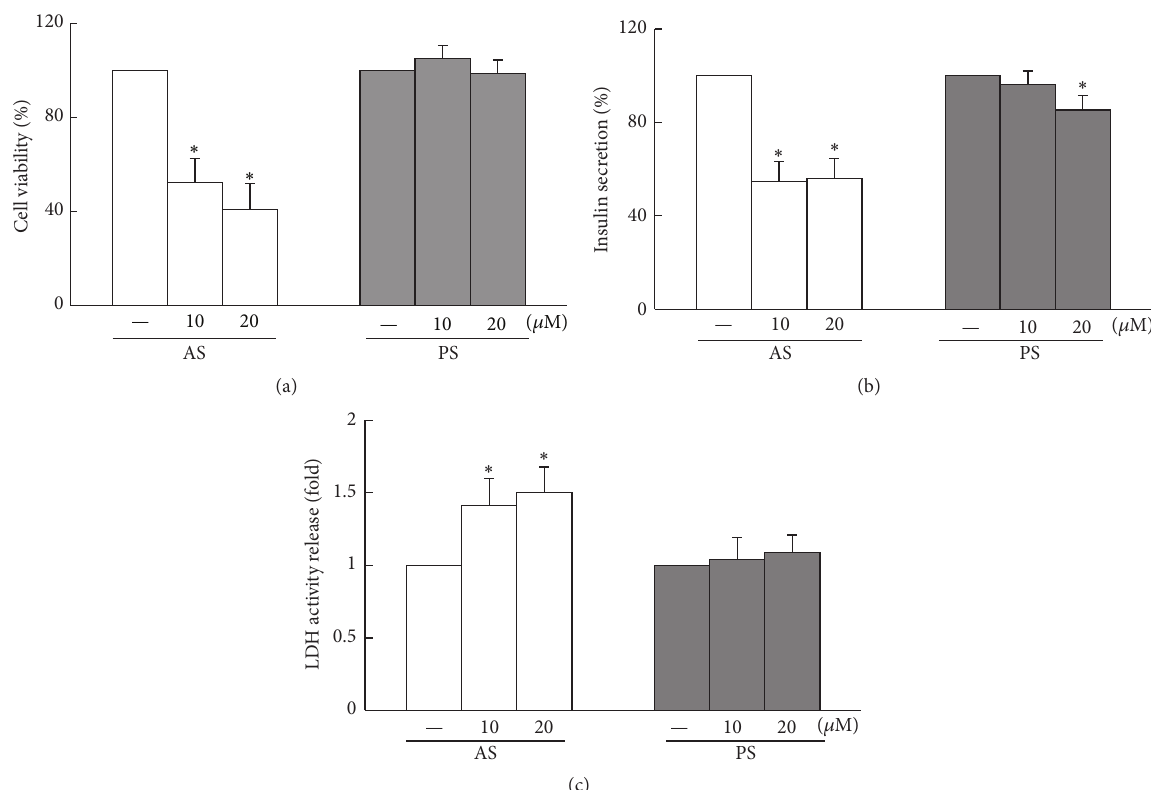
Figure 1: AS not only induces NIT-1 𝛽 cell death but also reduces insulin secretion. (a) Significantly dose-dependent cell death induced by AS in NIT-1 cells; no cell death in PS-treated cells. (b) Insulin secretion decreased considerably in NIT-1 cells after AS treatment and PS treatment with an increased dose. (c) The 48h incubation of AS evidently increased the content of LDH in NIT-1 cells. Data are presented as mean ± SD from three independent experiments ( ∗ 𝑃 < 0.05 compared to the untreated group, t -test). The value for the CON group was set at 1.